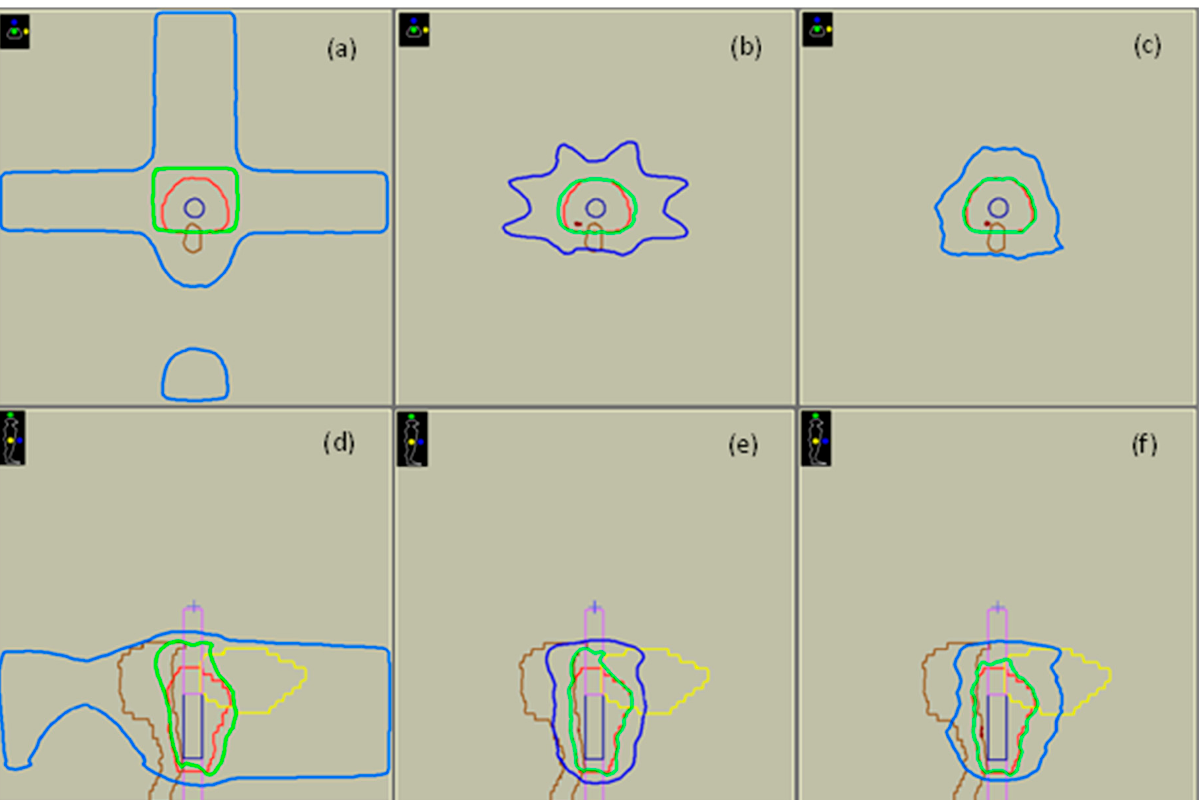
Figure 3. Screenshots from Monaco ® 5.11.02 TPS used for treatment planning and dose calculations presenting the isodose curves 105%, 95% and 50% of the prescribed dose superimposed on the central axial ( a – c ) and sagittal ( d – f ) slice of the blood tube for the 3D-CRT (left), IMRT (centre) and VMAT (right) treatment plan. Legend: red contour: PTV, brown contour: rectum, yellow contour: bladder, dark blue contour: blood tube, magenta contour: air-filled inserts, dark red line: 105% isodose, green line: 95% isodose, blue line: 50% isodose. Table 1. DVH parameters for the PTV and tube volume obtained for the 3D-CRT, IMRT and VMAT plans. Dosimetric